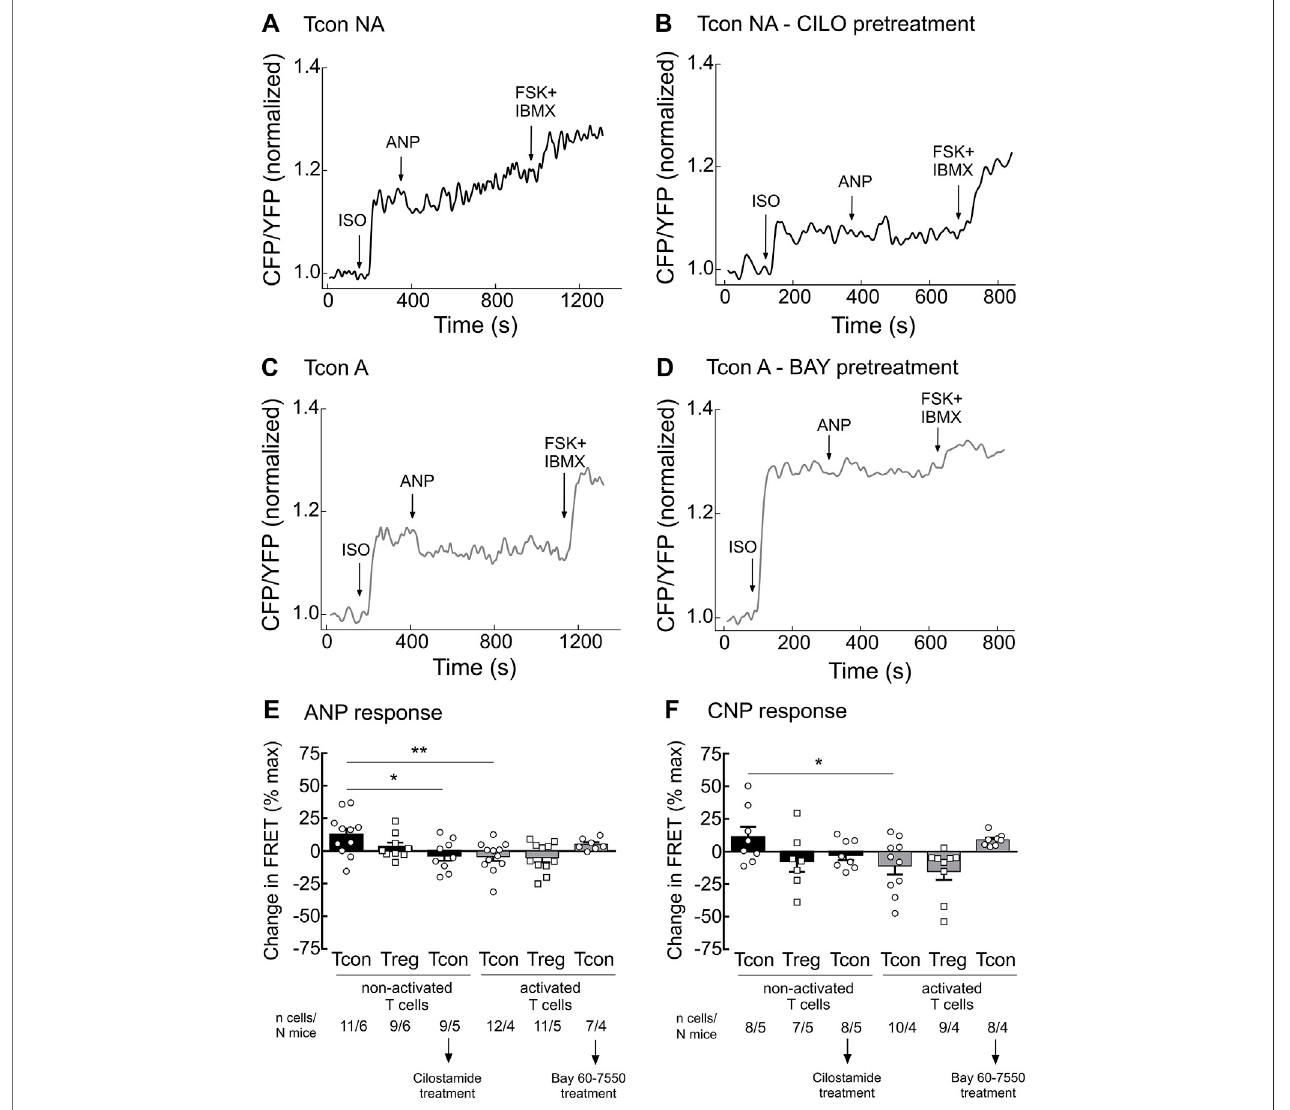
FIGURE 3 | Tconactivation changescGMP/cAMPcross-talkin responsetoNP.Primary TconandTregwereMACS-puri fi ed andculturedfor16 – 24 hin thepresenceor absence of anti-CD3/CD28 Dynabeads following FRET measurements. Representative FRET traces from Tcon expressing Epac1-camps sensor in (A) non-activated (NA), (B) non-activatedTcellsafterCILOpretreatment(10 µM), (C) activated,and (D) activatedTcellsafterBAYpretreatment(100 nM).Tcellswereinitiallystimulatedwiththenon-selective β -ARagonistisoprenaline(ISO,1 µM),toinducecAMPproduction.ChangeinFRETrepresentsacAMPresponsetoNPs(200 nMANPor300 nMCNP)ofindividualcellsas apercentofmaximalFRETbiosensorresponseinducedbyForskolin(FSK,10 µM)andIBMX(100 µM).DecreaseincAMPlevelisdepictedasanegativevalue. (E,F) Quanti fi cation ofFRETresponsesshownin (A – D) ,togetherwithdataobtainedfromTregmeasurementsaredepictedinthisbargraph.Resultsarepresentedasmean ± SEM.Cellnumberand totalnumberofmicemeasuredpergroupareindicatedbelowthebars.* p < 0.05;** p < 0.01;ns – notsigni fi cantbyone-wayANOVAfollowedbySidak ’ smultiplecomparisontest.